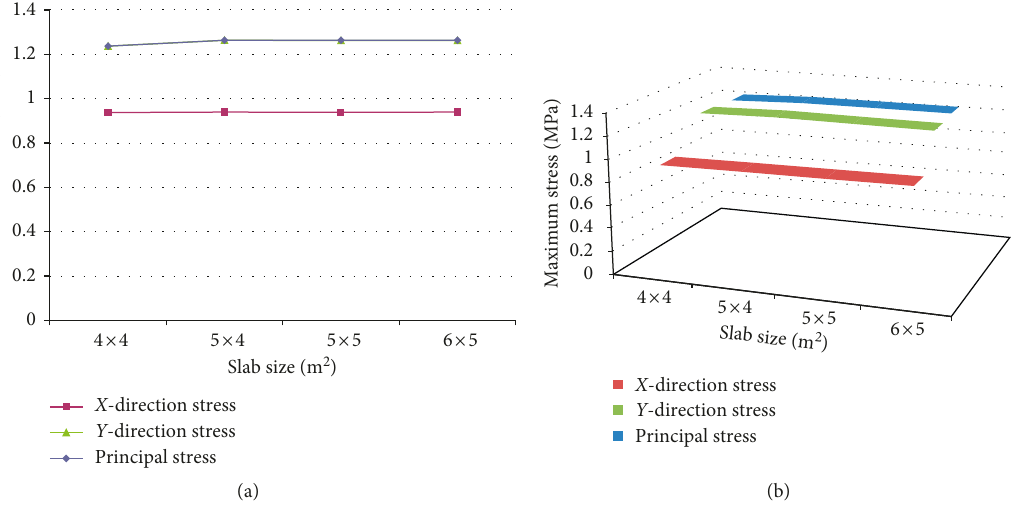
Figure 23: Variation of original surface layer stress with slab size: (a) two-dimensional broken-line graph; (b) three-dimensional broken- line